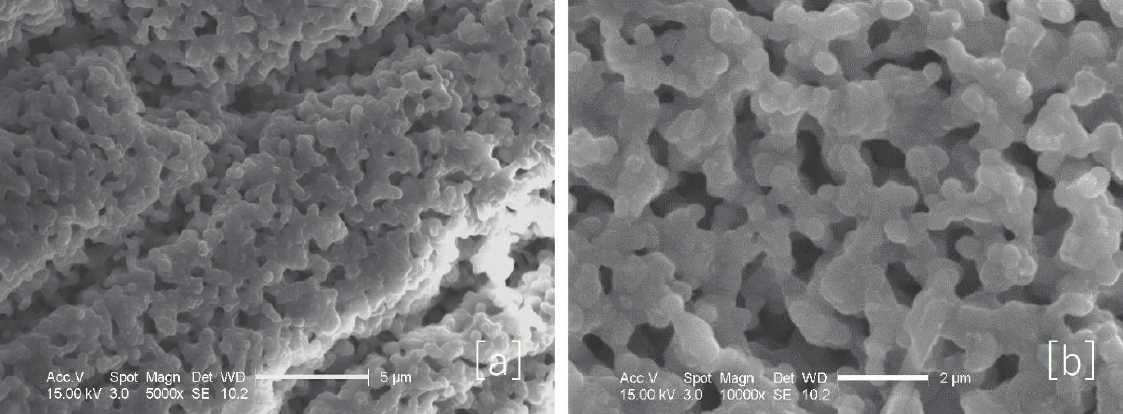
Fig. 7 Surface of the SO grain after thermal activation at 523 K, BSE, magnification: a) 5000x, b) 10000x Modification of ground NaHCO 3 (SOm) at 373 K resulted in developing numerous small pores which only partially covered the surface (Fig. 8). As the thermogravimetric